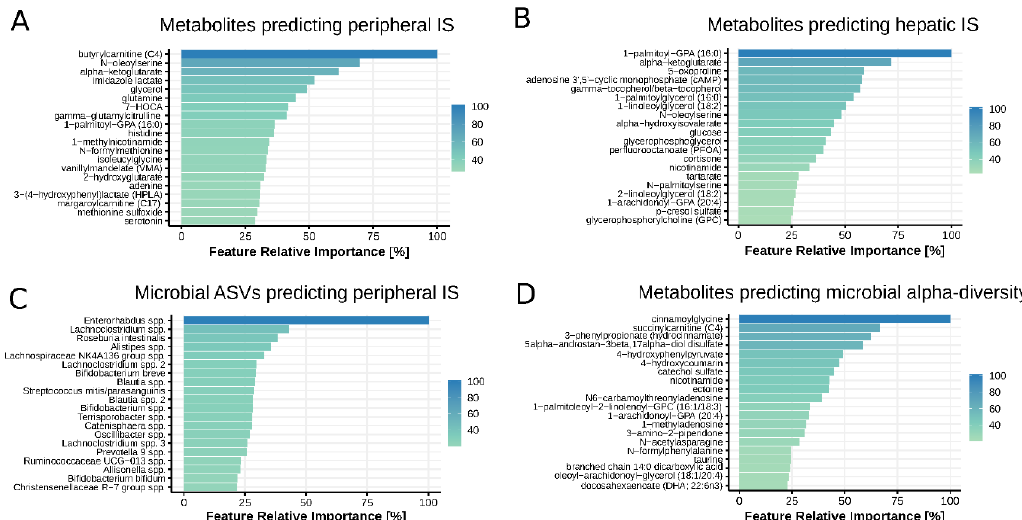
Figure 2. Feature importance plots. Overview of top 20 features (metabolites or microbial ASVs) explaining variance in insulin sensitivity and gut microbial alpha-diversity best. ( A ) Metabolites explaining variance in peripheral insulin sensitivity, ( B ) Metabolites explaining variance in hepatic insulin sensitivity, ( C ) Microbial ASVs explaining variance in peripheral insulin sensitivity, and ( D ) Metabolites explaining variance in gut microbial alpha-diversity. ASV: amplicon sequence variant.